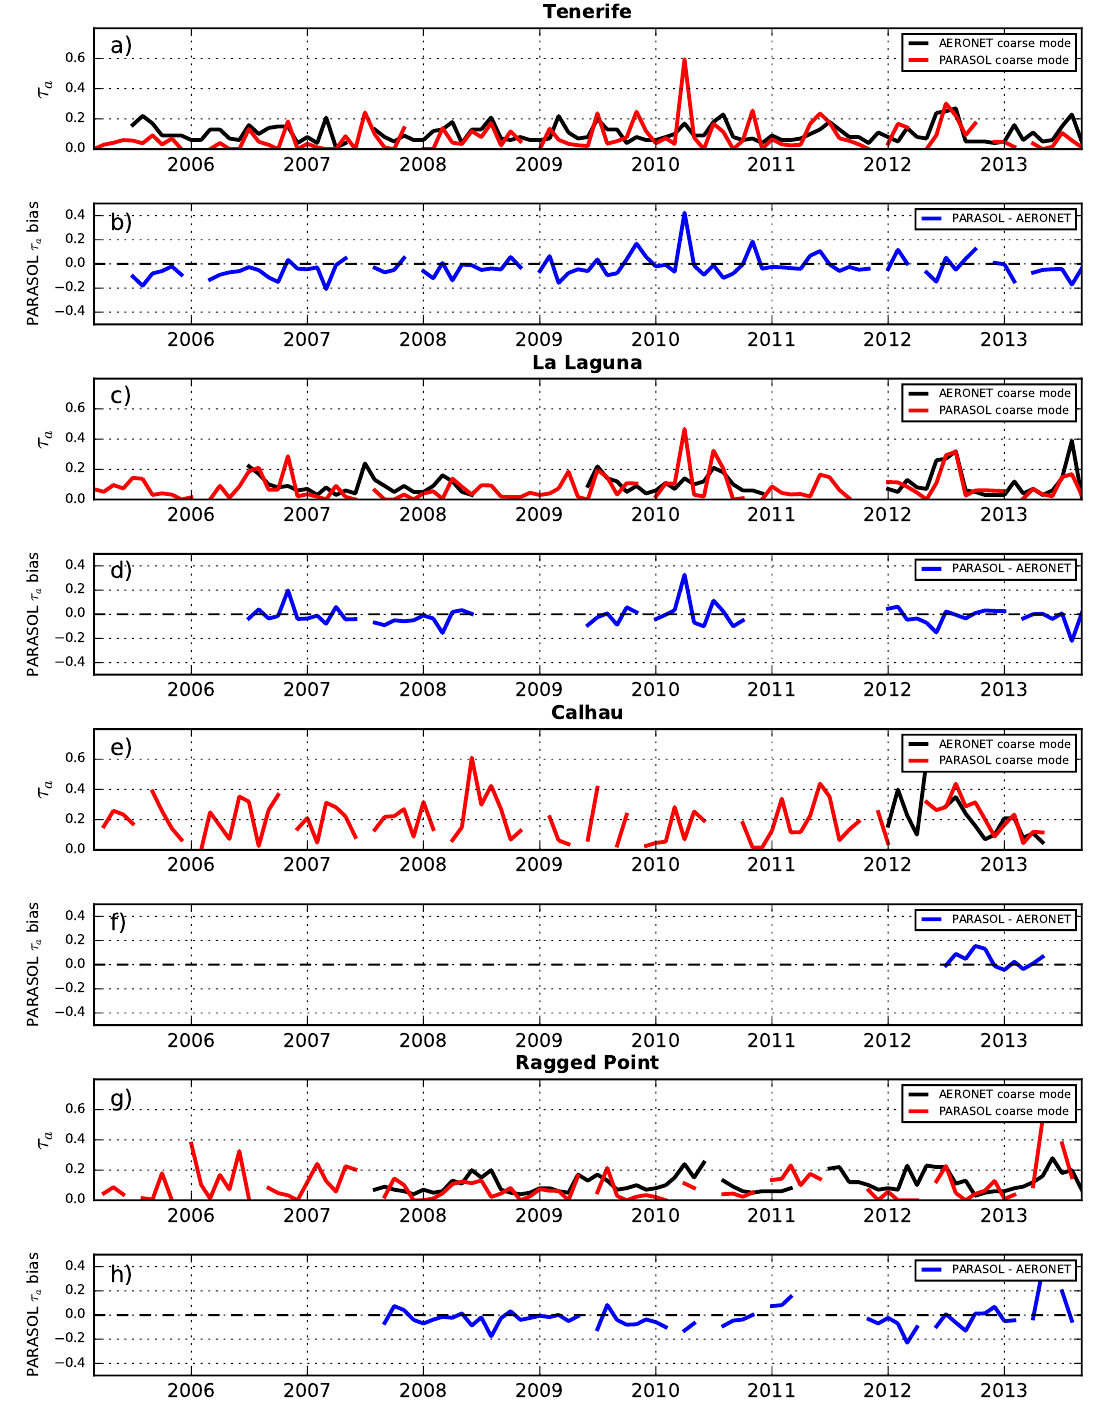
Figure 4. Similar as Figure 2 but for AOD c (coarse mode of aerosols): ( a ) Tenerife, ( c ) La Laguna, ( e ) Calhau and ( g ) Ragged Point. Corresponding PARASOL AOD c bias with respect to AERONET: ( b ) Tenerife, ( d ) La Laguna, ( f ) Calhau and ( h ) Ragged Point. PARASOL observations of both AOD and AOD c exhibit satisfactory correlation